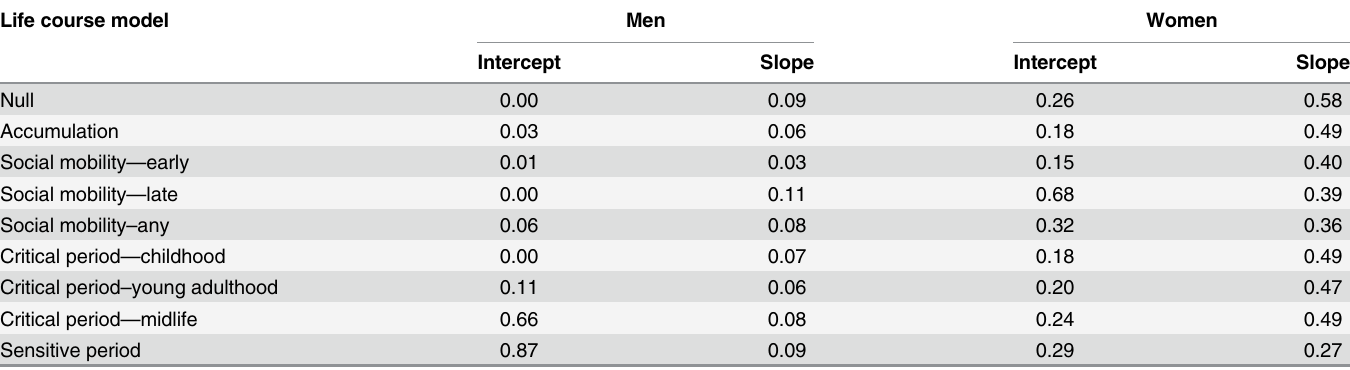
Table 6. Relative model fit of life course model (p-value).